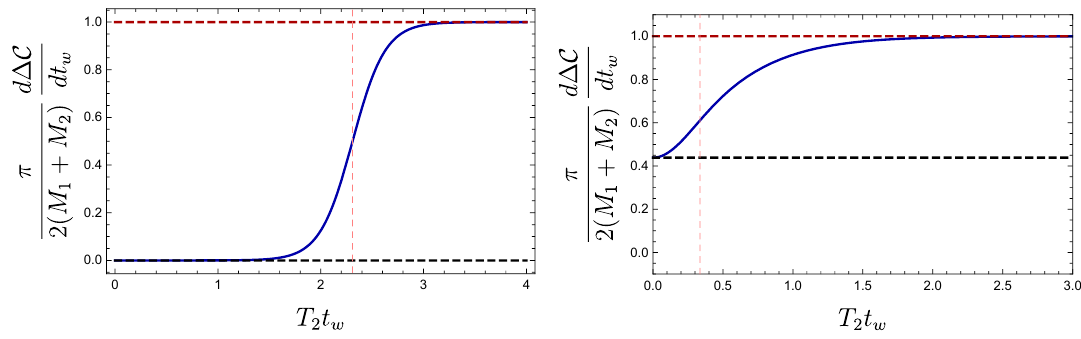
Figure 8. The derivative of the complexity of formation with respect to t w . The black dashed line is the expected slope at t w = 0, and the dashed red line is the slope at large t w (normalized in the plot to approach 1). For both panels, we adopt z = 1 =w . The left panel illustrates the behaviour for a light shock wave, with w = 1 + 10 (cid:0) 6 . In this regime, described by eq. (3.84), the slope is approximately zero until t t (cid:3) (vertical dashed line), at which point it rapidly rises to the (cid:12)nal scr ’ constant value, 4 M 1 =(cid:25) . The right panel illustrates the behaviour for a heavy shock wave, with w = 2. In this regime, the slope starts at (cid:13) 0 in eq. (3.85) and rapidly rises to the (cid:12)nal constant value 2( M 1 + M 2 ) =(cid:25) . In this case, the vertical dashed line indicates t w = t del from eq.